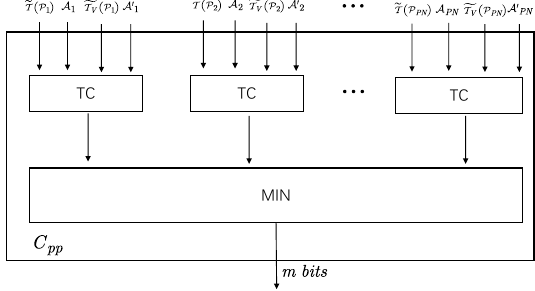
Figure 6. The path-planning circuit C pp . Phase 2. (Riders Selection) In this phase, for all rider combinations C = system compares their ATT and outputs the best combination, in which CN is